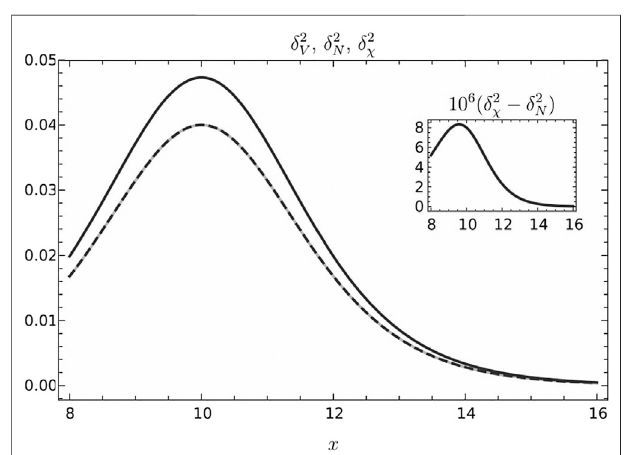
FIGURE 2 | Plot of δ 2 V (dark solid line), δ 2 χ (dark dashed line) and δ 2 N (light solid line) as functions of x ≡ 2 μ χ 0 around the bounce x (cid:2) 10 for μ j